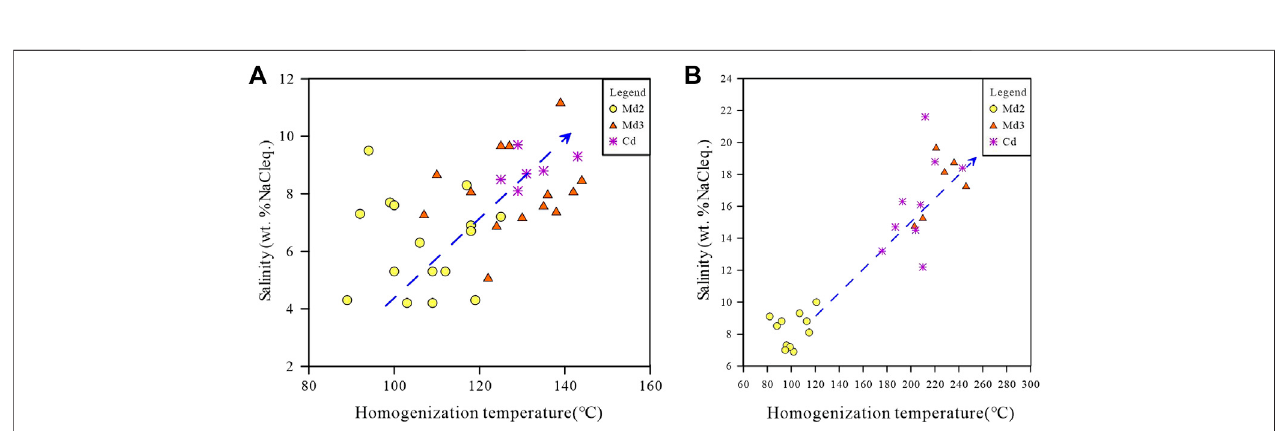
FIGURE11| Cross-plotofhomogenizationtemperatures(T h )versussalinity(calculatedfrom fi nalmeltingtemperatures(T m ))from fl uidinclusionsofMd2,Md3,and Cd. (A) Northwestern (NW) study area; (B) southwestern (SW) study area.